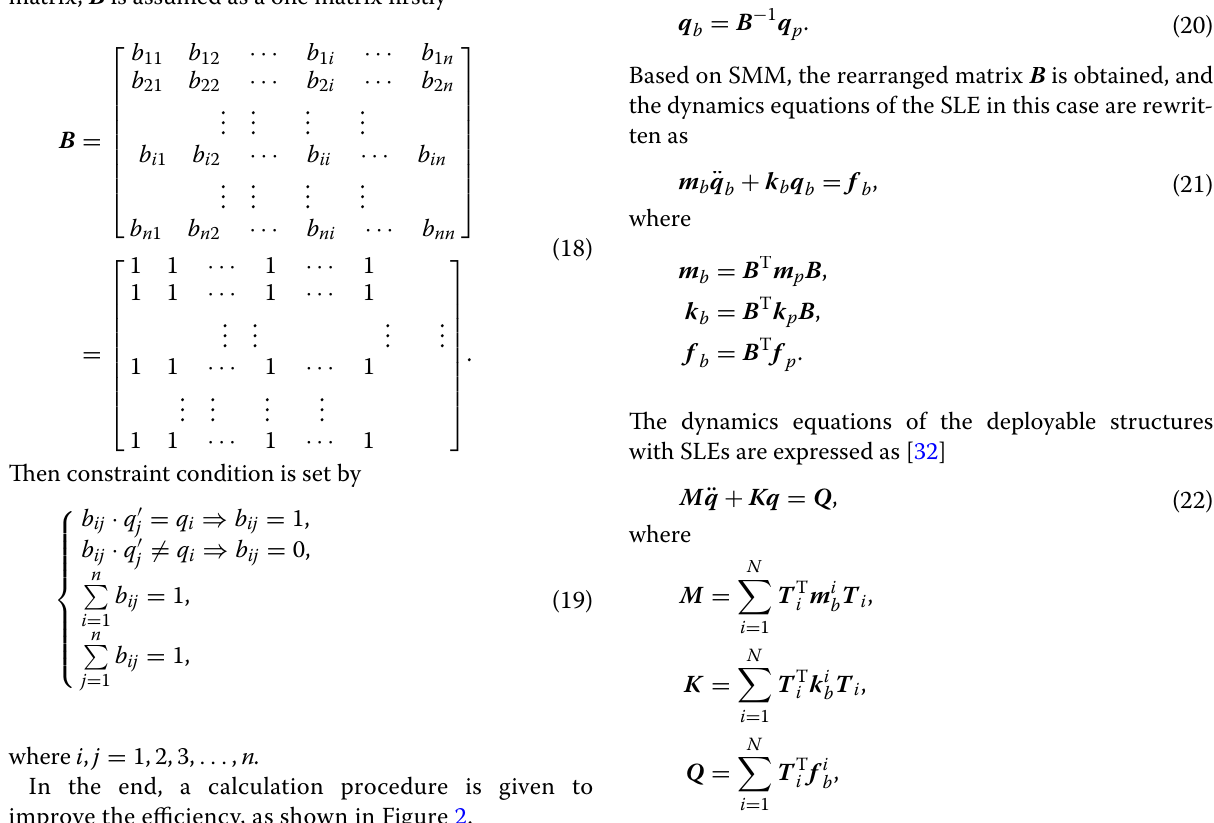
3.2 Flexible Dynamics Equations of Deployable Structures with SMM The uniform form of the generalized coordinate vector of the SLE is